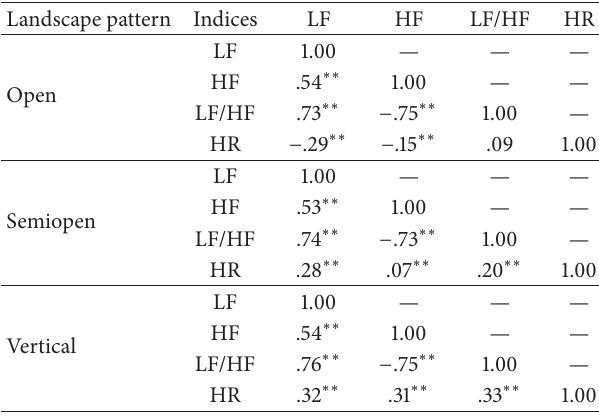
Table 3: Correlation analysis of ECG indices in each